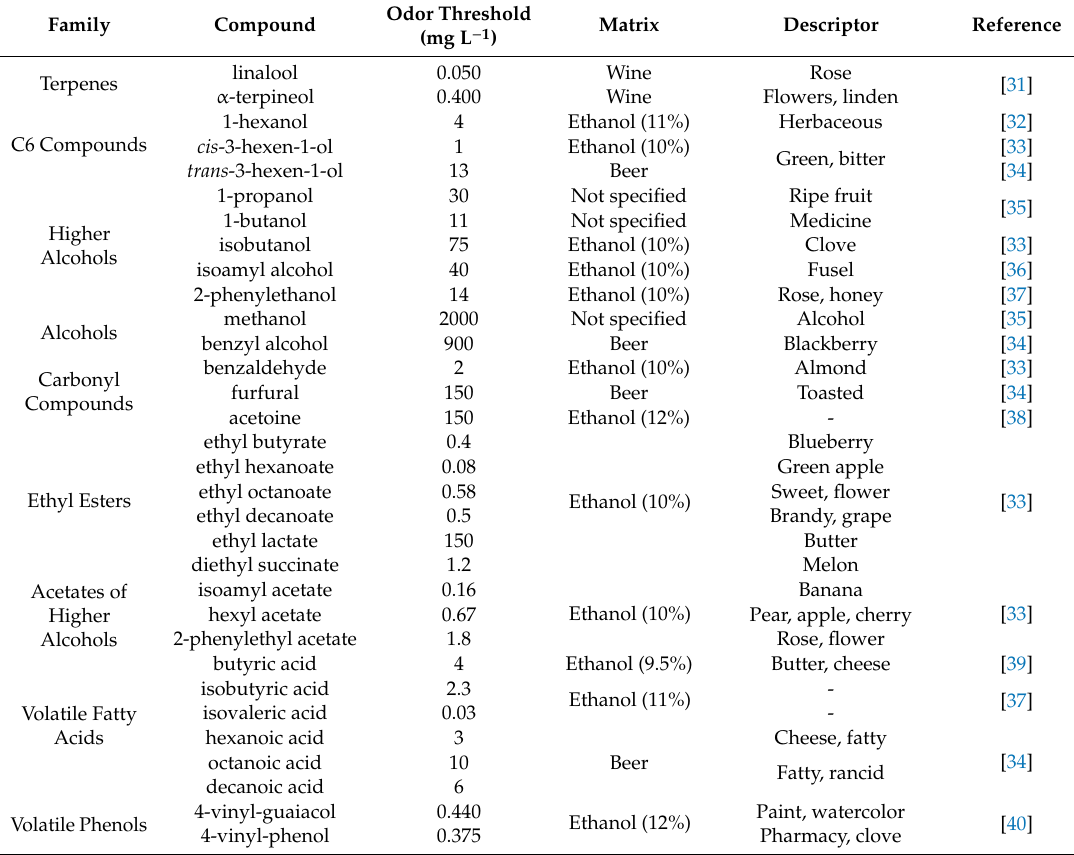
Table 1. Odor thresholds, matrix in which they were obtained, and descriptors for several volatile compounds. References for the thresholds are